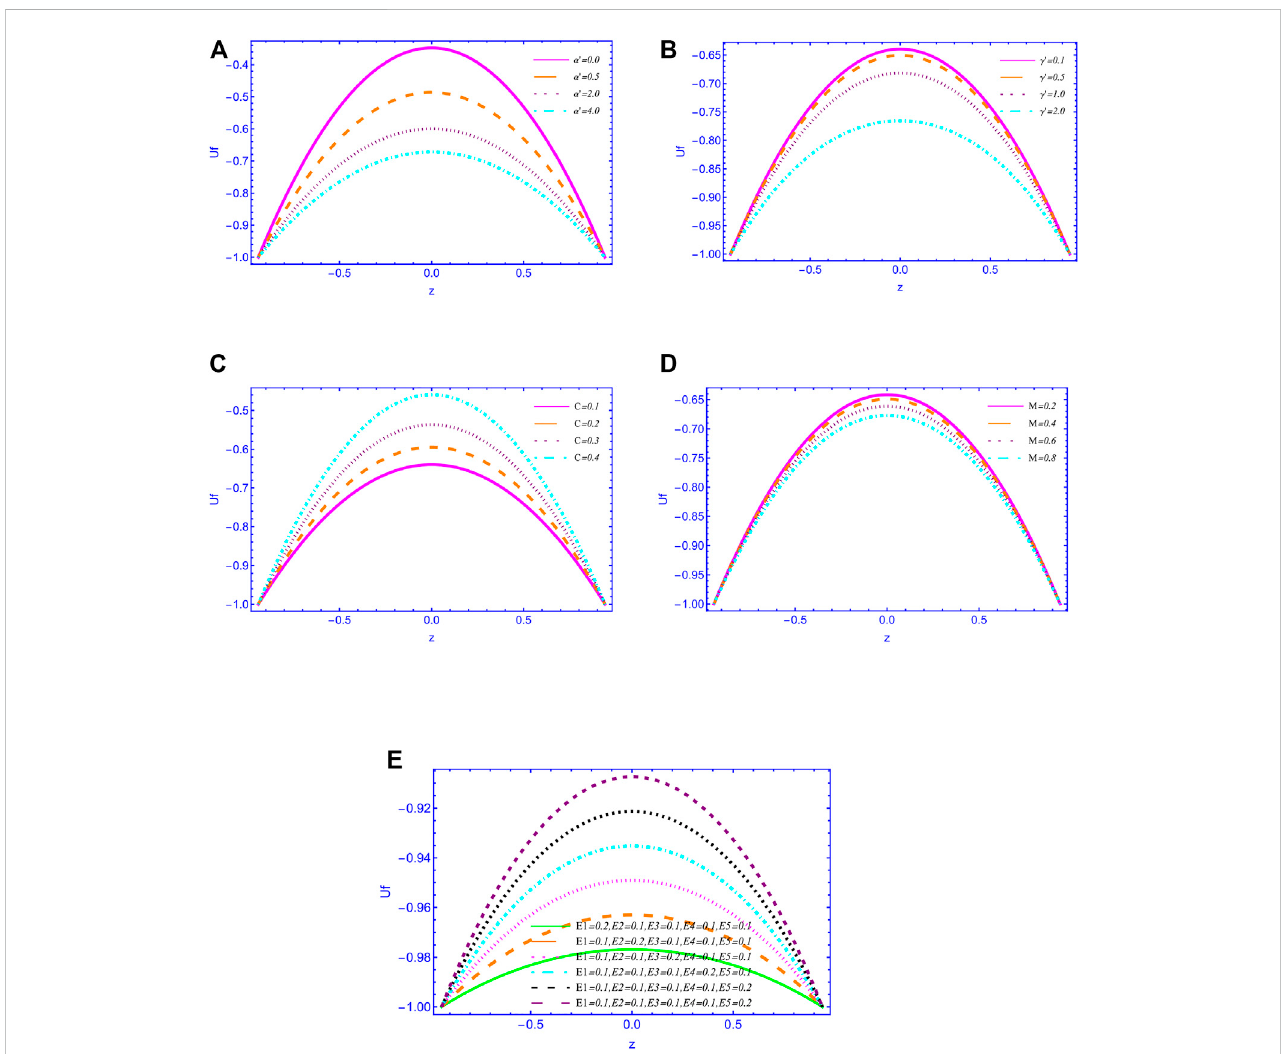
FIGURE 2 (A) represents the various values of α ′ on u f when M , C , γ ′ (cid:2) 0 . 1. (B) represents the various values of γ ′ on u f when M , C , (cid:2) 0 . 1 , α ′ (cid:2) 1 . 0. (C) represents the variousvaluesofCon u